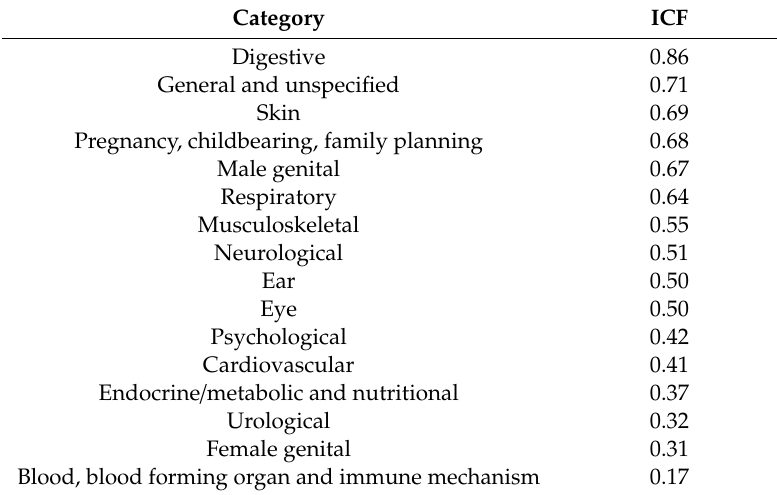
Table 1. Informant Consensus Factor (ICF) values for Thai gingers in each ICPC-2 category, as reported in 62 references.